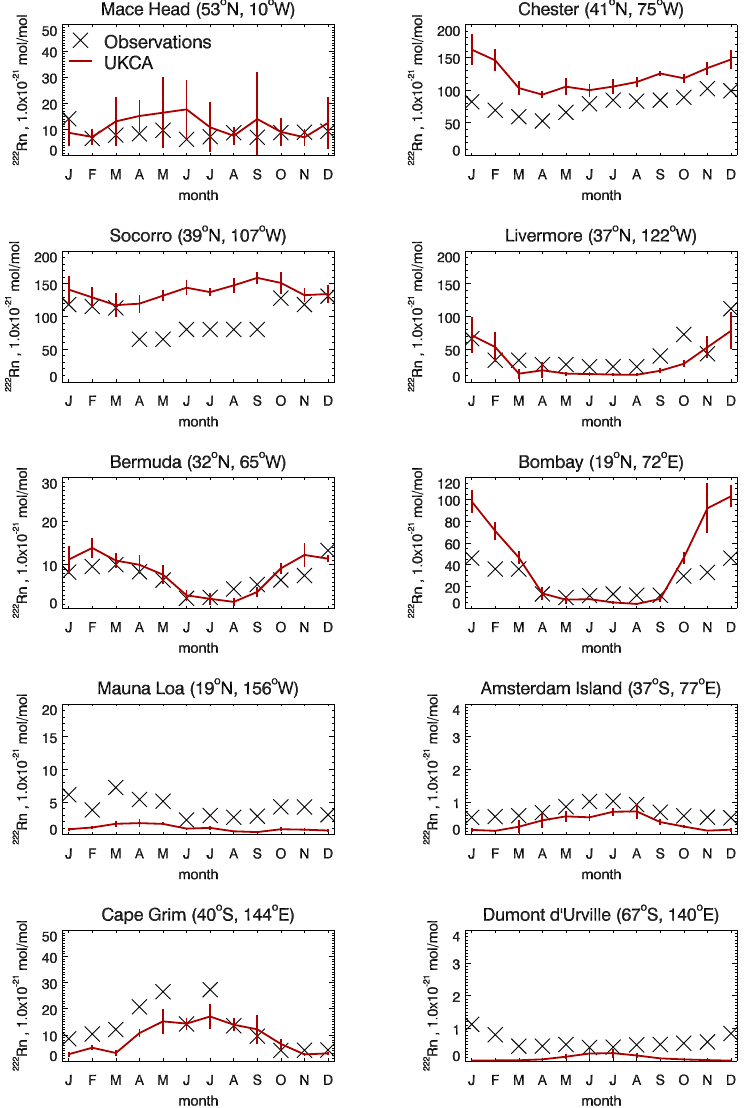
Fig. 3. Comparison of modelled multi-annual monthly mean surface radon concentrations in units of 10 − 21 mol mol − 1 with surface obser- vations for a number of sites spanning the latitude range 53 ◦ N–67 ◦ S. Observations are shown as black crosses and the UKCA model is shown in red. The red vertical lines represent ± 1 standard deviation about the modelled multi-annual monthly mean values. Measurements are taken from Hauglustaine et al. (2004) and references therein.